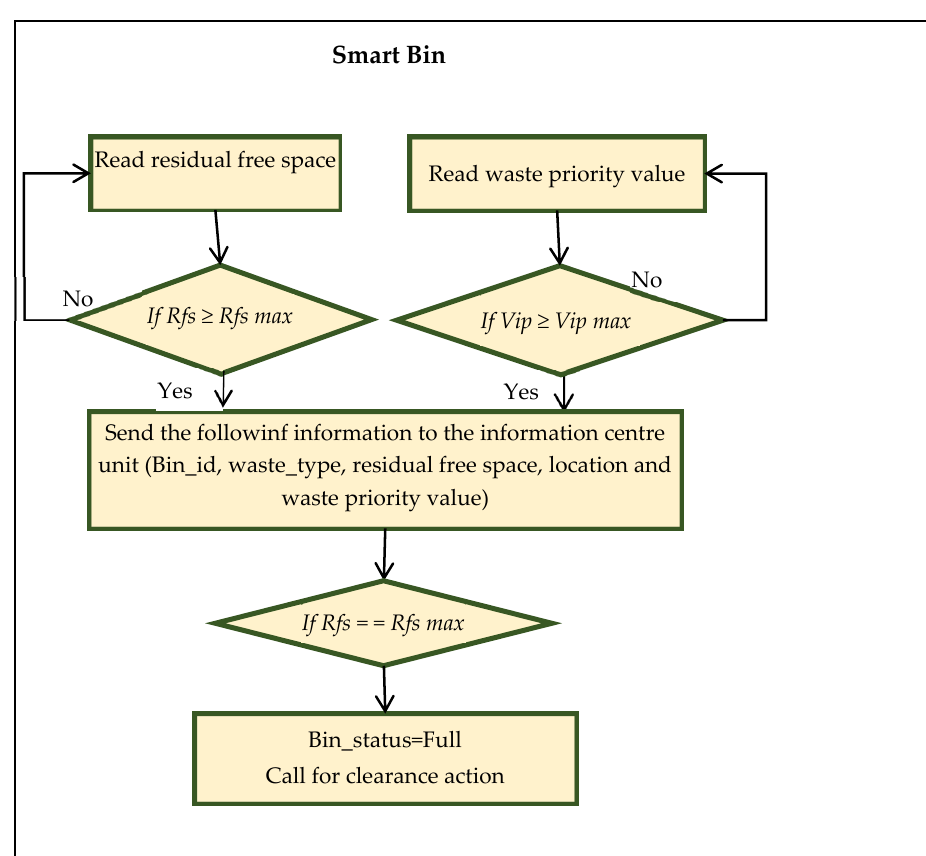
Figure 11. Intelligent smart bin handling information.